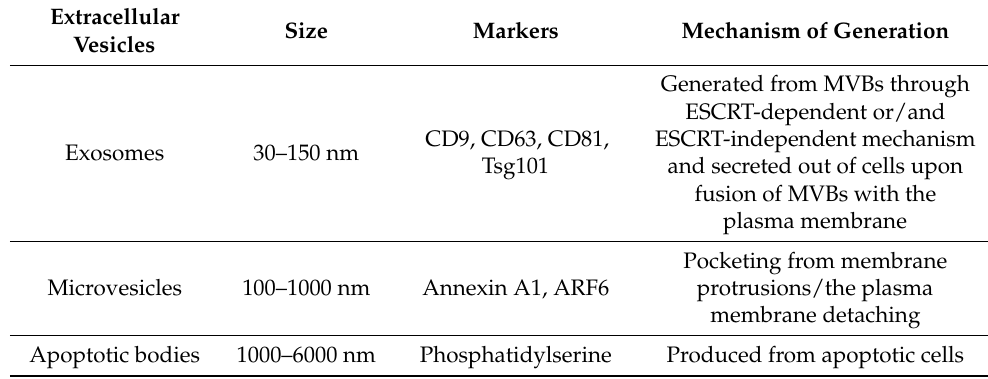
Table 1. Types of extracellular